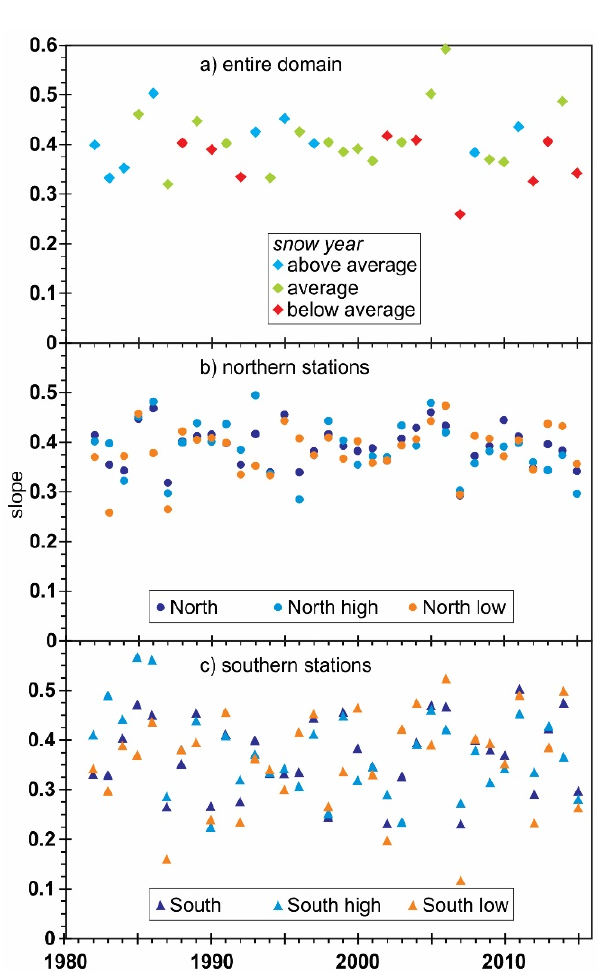
Figure 5. Mean accumulation slopes per year from the standard deviation versus mean trajectories for ( a ) the entire domain, ( b ) the north station sub-sets, and ( c ) the south station sub-sets. The station subsets are further divided into high and low elevation.